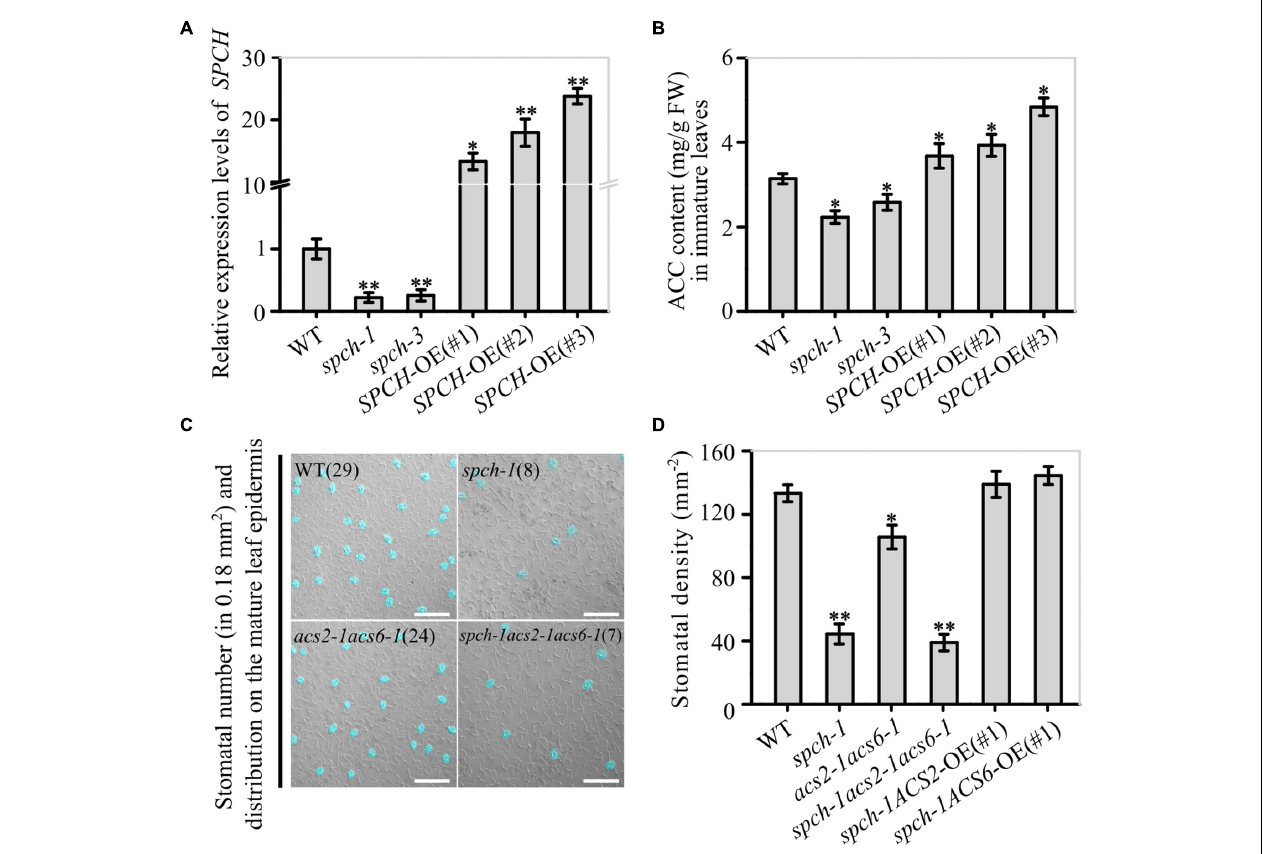
FIGURE 5 | Correlation between SPCH activity and ACS2/6-dependent ACC accumulation and stomatal density and pattern. (A,B) RT-qPCR-based relative levels of SPCH mRNA transcripts and ACC content in immature leaves of WT control, loss-of-function mutant spch-1 and spch-3 , and SPCH -overexpressing SPCH -OE(#1), SPCH -OE(#2), and SPCH -OE(#3) plants. The ACTIN8 gene was used as an internal control. The experiment was repeated three times with consistent results. Values are means ± SD (Student’s t -test; ∗ P < 0.05; ∗∗ P < 0.01). (C,D) DIC images and statistical summary of stomatal density and patterning on the abaxial epidermis of spch-1 , acs2-1acs6-1 , and spch-1acs2-1acs6-1 plants. Numbers of stomata are indicated in parentheses in each image. Stomata are false colored in blue for easier identification. The white scale bar represents 100 µ m (C) . Stomata on sixth leaves of 25 seedlings were counted (D) . Values are means ± SD. Significant differences are indicated by asterisks (Student’s t -test; ∗ P < 0.05; ∗∗ P <